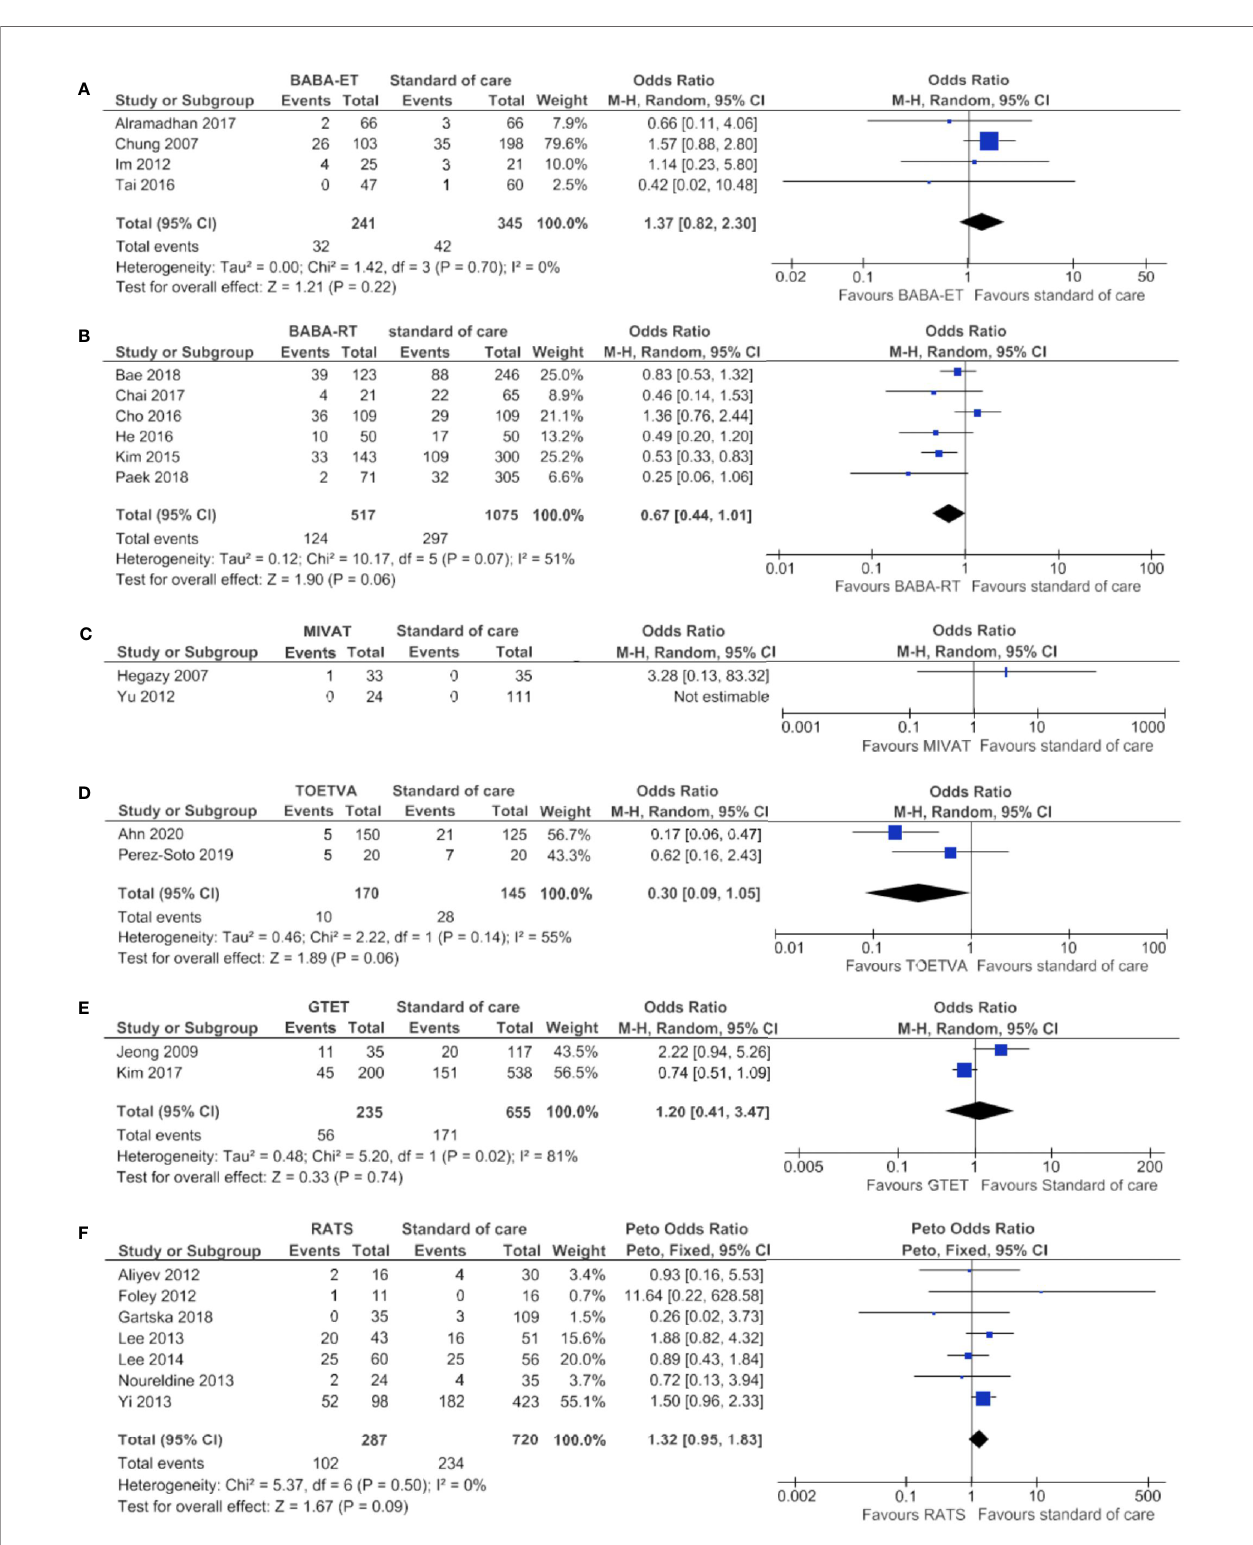
FIGURE 7 | Forests plots of transient hypocalcemia for (A) BABA-ET, (B) BABA-RT, (C) MIVAT, (D) TOETVA, (E) GTET and (F)